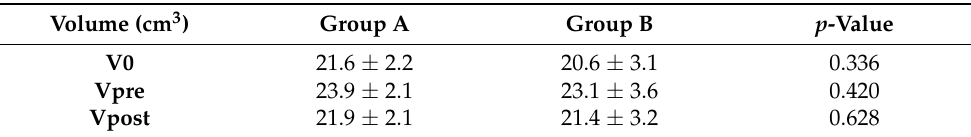
Table 2. Surgical outcomes: comparison of group A and group B. (V0: orbital volume of the normal side; Vpre: preoperative orbital volume of the lesion side; Vpost: postoperative orbital volume of the lesion